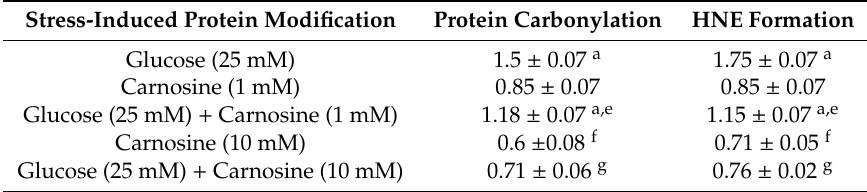
Table 2. Oxidative stress-induced protein carbonylation and 4-hydroxynonenal (HNE) formation. Carnosine reduced glucose-induced protein carbonylation and formation of HNE. The derivatized proteins were separated by SDS / PAGE (Figures 5 and 6), quantified and normalized to untreated cells.